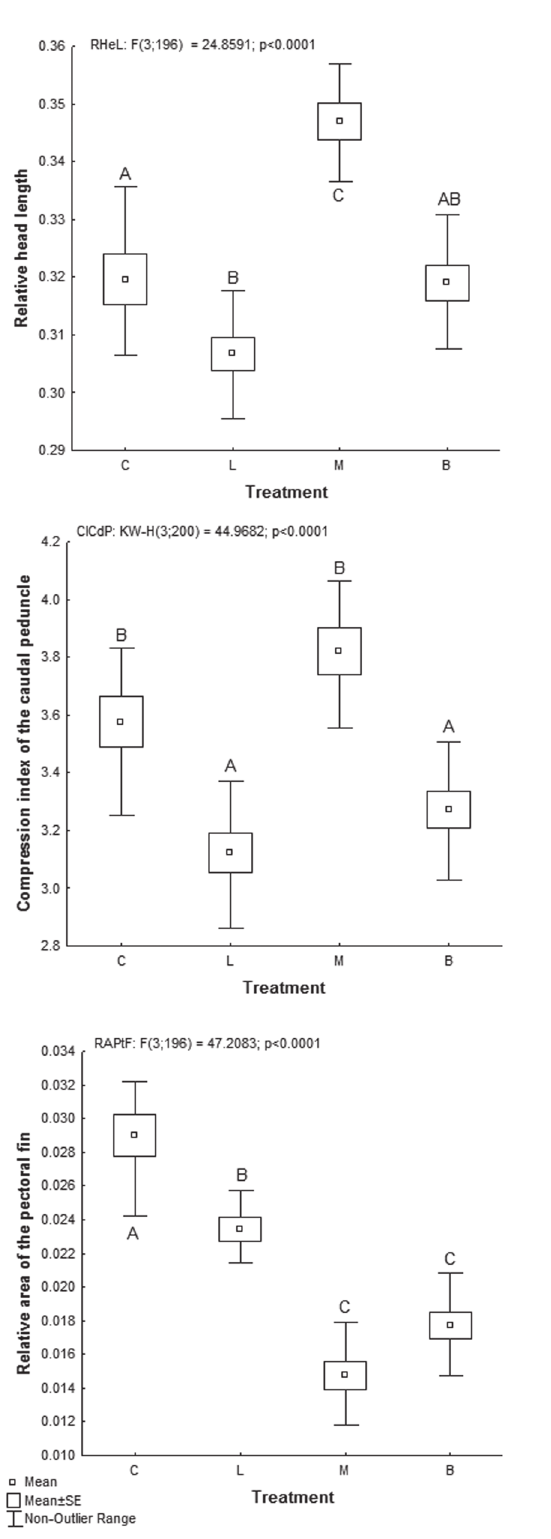
Fig. 5. Most important ecomorphological attributes for Prochilodus lineatus in the morphological differentiation among treatments, according to the ANOVA and the DCA, concomitantly. Treatments with a different letter above their ranges differed